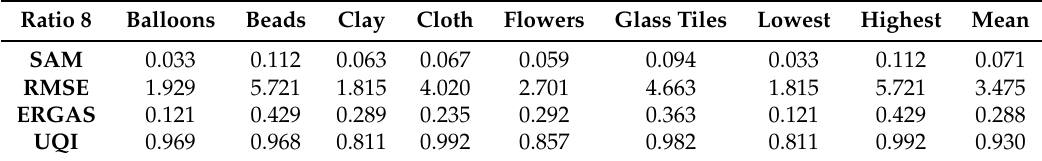
Table 3. Spectral quality indexes for the higher spatial resolution CAVE images trained with input of 64 × 64 pixels.